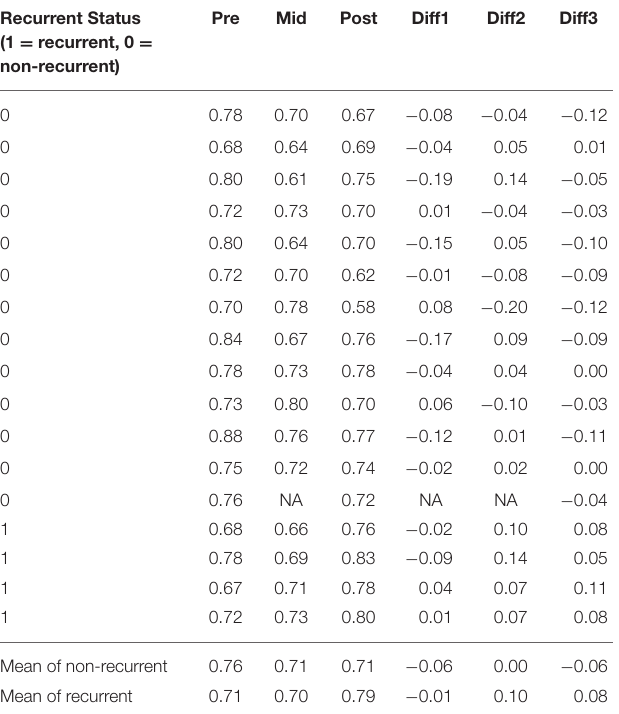
TABLE 5 | The roundness of each patient at Pre-CRT, Mid-CRT, and Post-CRT and their differences. Recurrent Status (1 = recurrent, 0 =